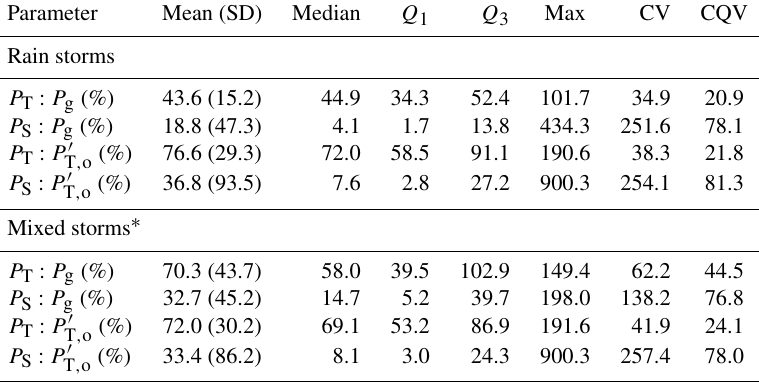
estimate by T , o